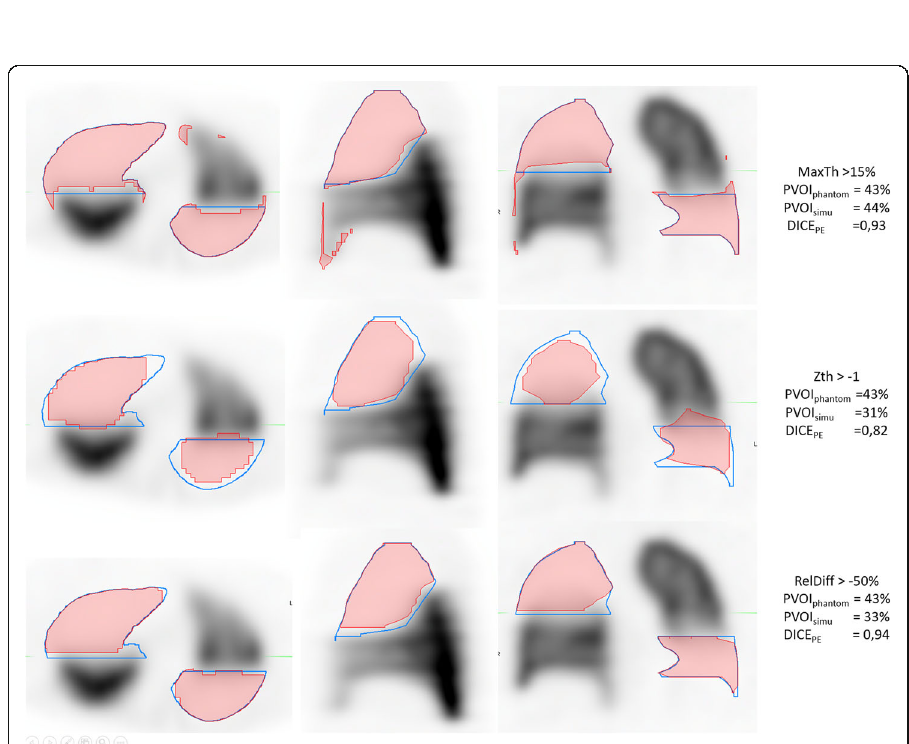
Fig. 9 Example of segmentation for a massive PE (red) using the MaxTh method (first row), the Zth method (second row), and the RelDiffTh method (third row). Ground truth is delineated in blue. MaxTh showed good correlation in PVOI assessment, but wrongly delineated areas without PE. RelDiff Method showed an underestimation of PVOI, but a good spatial